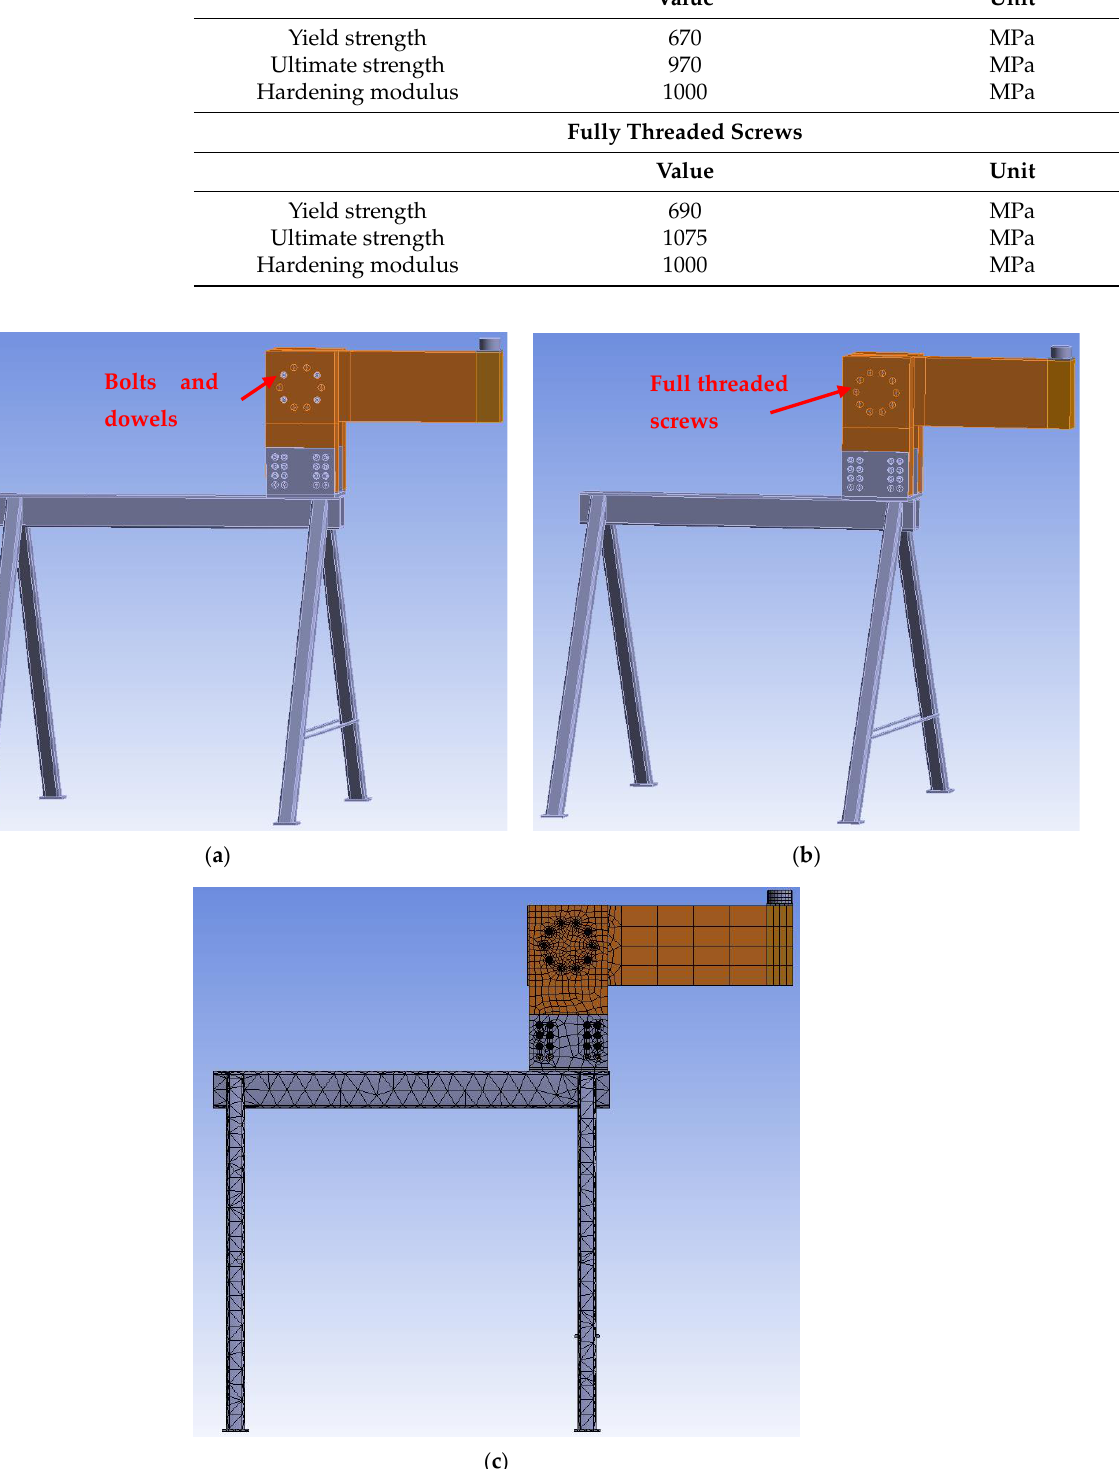
Figure 8. Boundary conditions of the numerical models. It is very important to correctly apply the load into the numerical model. Figure 9 shows the finite element mesh for both numerical models for applying the load using the press head (cylinder) of the testing machine. The model was loaded as vertical displacement (displacement-controlled loading), which represented the actual loading by the cylinder during the experimental testing. The numerical model used the Newton – Raphson incremental – iterative method. The number of increments was the selected logic setting of the Ansys TM software [47], with an initial step of 0.001 s and a maximum step of 0.04 s.